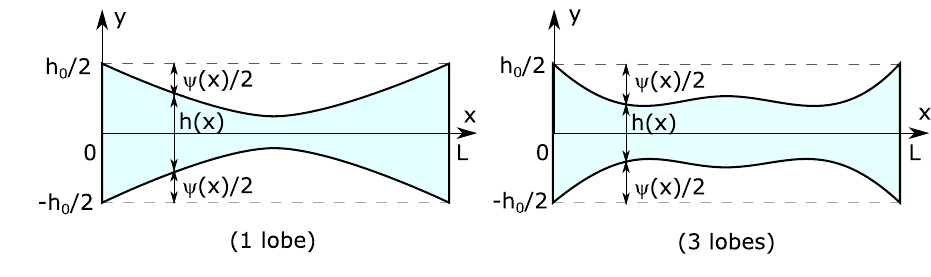
Fig. 2 Numerical adopted model neglecting the pre- existing curvature of the axis of the emptied beam for a double fixed beam using an empty function with a one single sine (left) and two sine (right)